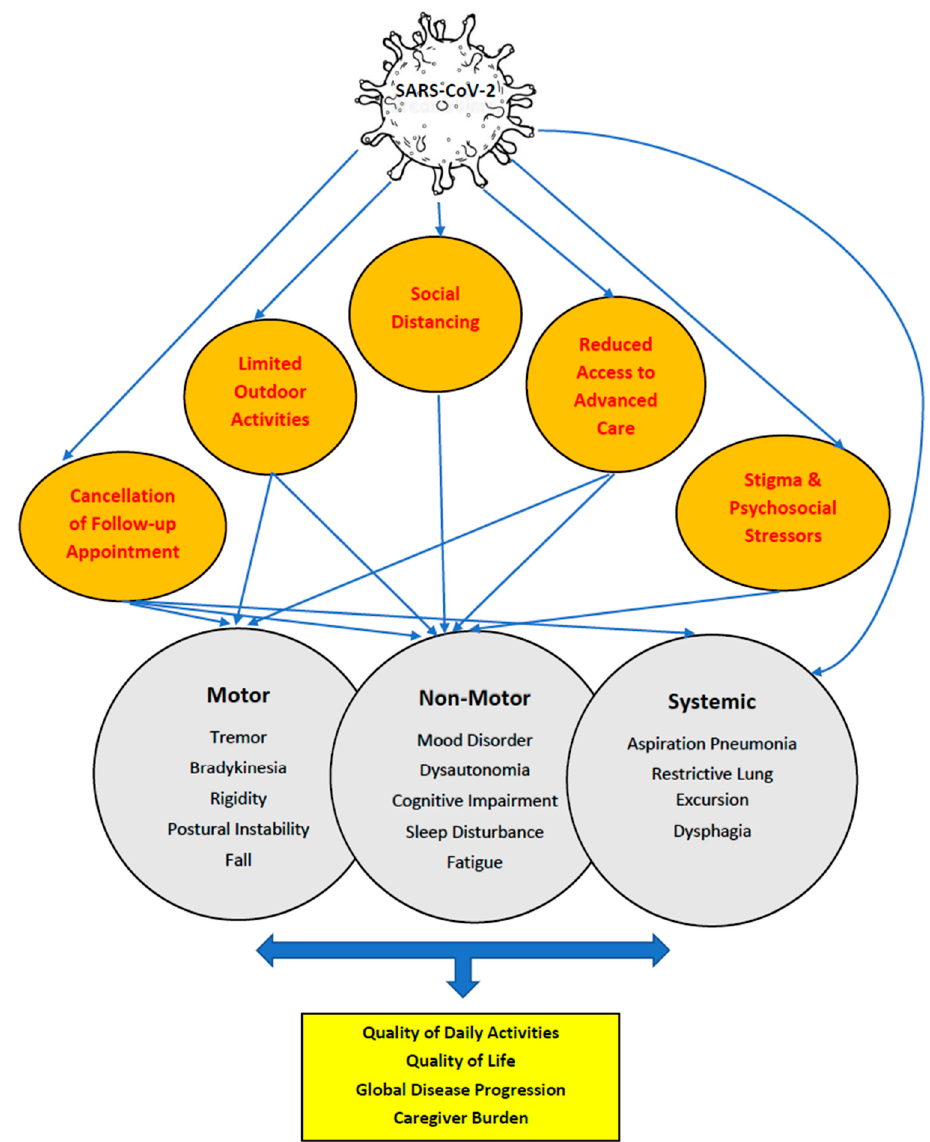
Figure 1. Various aspects of COVID-19 pandemic affecting different aspects of care in Parkinson’s disease (PD) with direct or indirect impact on PD manifestations (motor and non-motor), systemic health and eventually quality of life and their caregiver burden.